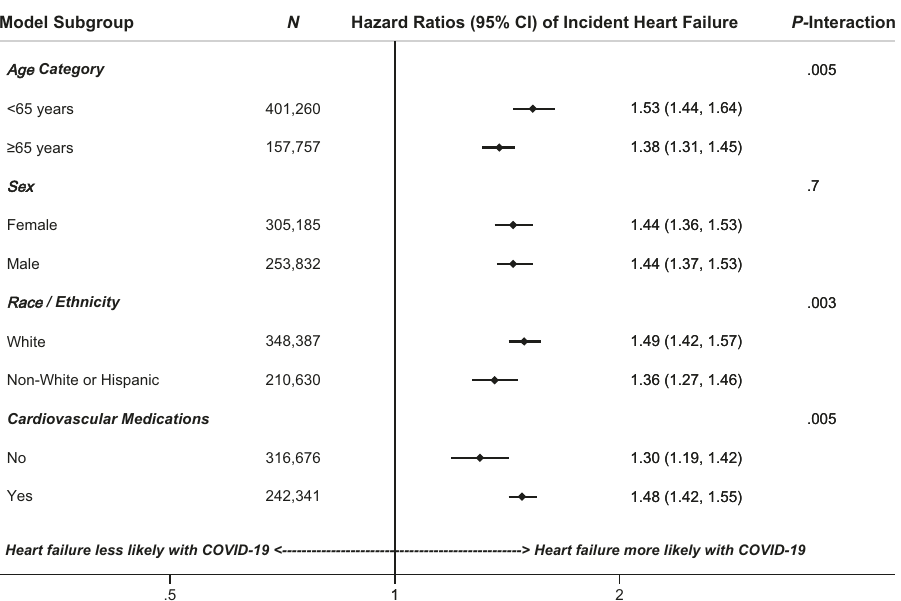
Fig. 2 Adjusted hazard ratios of incident heart failure comparing patients hospitalized with versus without COVID-19. Multivariable Cox regression models based on a total of 559,017 unique patients without missing age, race/ethnicity, or sex. Models adjusted for demographics (age, race/ethnicity, sex), heart failure risk factors (hypertension, obesity, coronary artery disease, diabetes, chronic kidney disease, chronic lung disease) and cardiovascular medications (angiotensin converting enzyme inhibitor, angiotensin II receptor blocker, beta blocker, and statins). Point = hazard ratio, horizontal bars = 95% con fi dence intervals, vertical bar = null value (hazard ratio = fi rst. Potential modi fi cation of the association between post-recovery COVID-19 with incident HF was assessed by strati fi cation (age ≤ 65 vs. 65 years), (females vs. males), (White vs. non-White race/ethnicity), and (cardiovascular medica- tion use vs. no use). Race/ethnic groups were categorized as White vs. non- White to analyze potential modi fi cation by racial or ethnic minority status. Signi fi cance of the effect modi fi cation was assessed by testing by the multi- plicative interaction of the stratifying variable with post-recovery COVID- 19 status. Because elevated natriuretic peptides at the index hospitalization may indicate existing, undocumented HF, we conducted a sensitivity analysis excluding any patients identi fi ed with elevated BNP or NT-proBNP. Reporting summary . Further information on research design is available in the Nature Research Reporting Summary linked to this article.